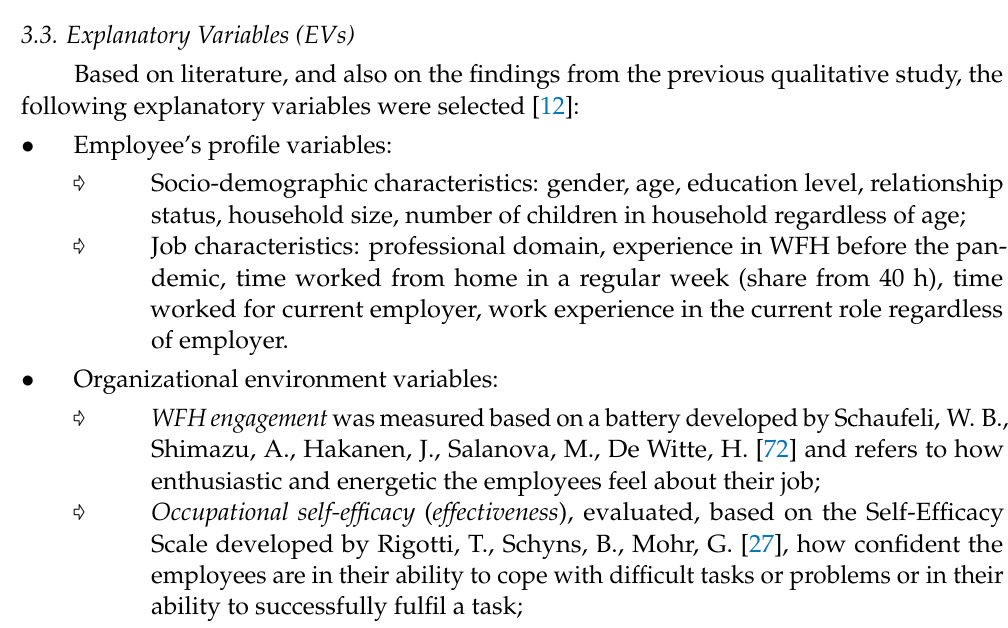
Figure 1. Self-assessed social and technical performance.